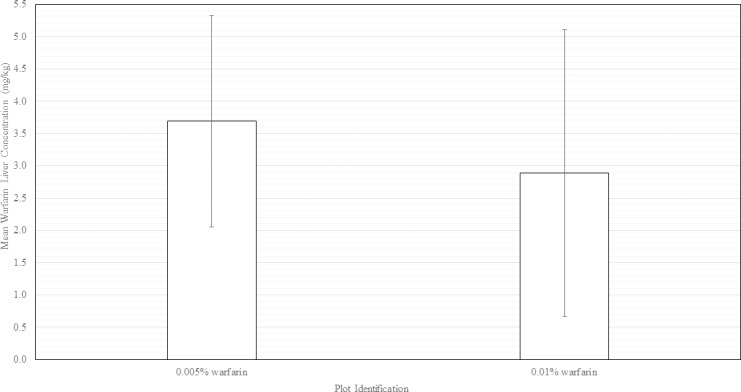
Mean warfarin residue concentrations (mg/kg) in liver samples detected via High Performance Liquid Chromatography (HPLC).Vertical bars indicate ± SE.